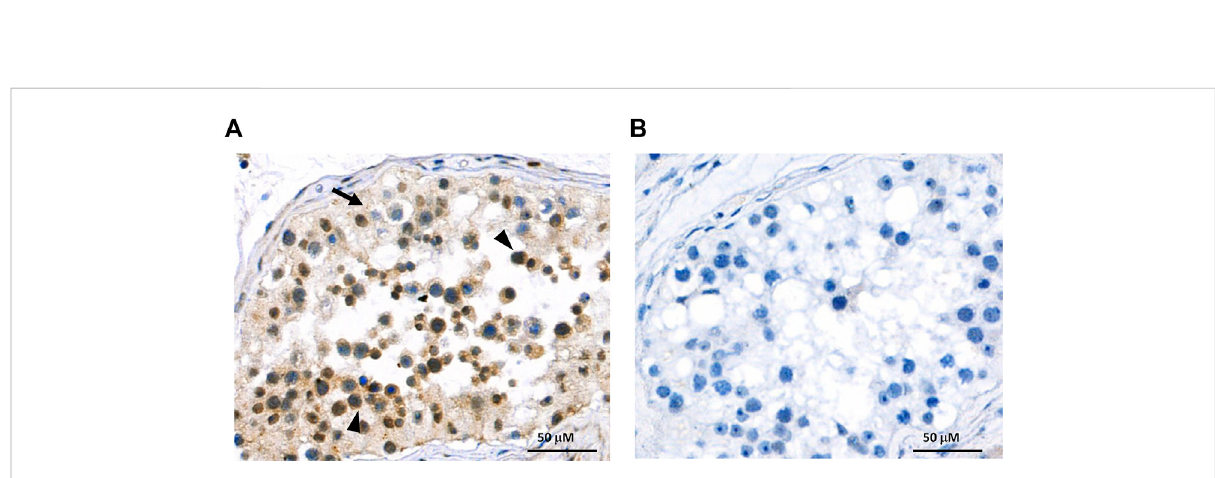
FIGURE 5 Immunohistochemical localization of OATP3A1_V3 in the human testis. (A) Paraf fi n-embedded testis section was stained with the anti- OATP3A1_V3 antibody and visualized by polymer-based detection. Positive staining was observed in germ cells (arrowhead) with limited labeling detected in Sertoli cells (arrow). Nuclei were counterstained with hematoxylin. (B) Negative control staining was performed in the absence of the primary